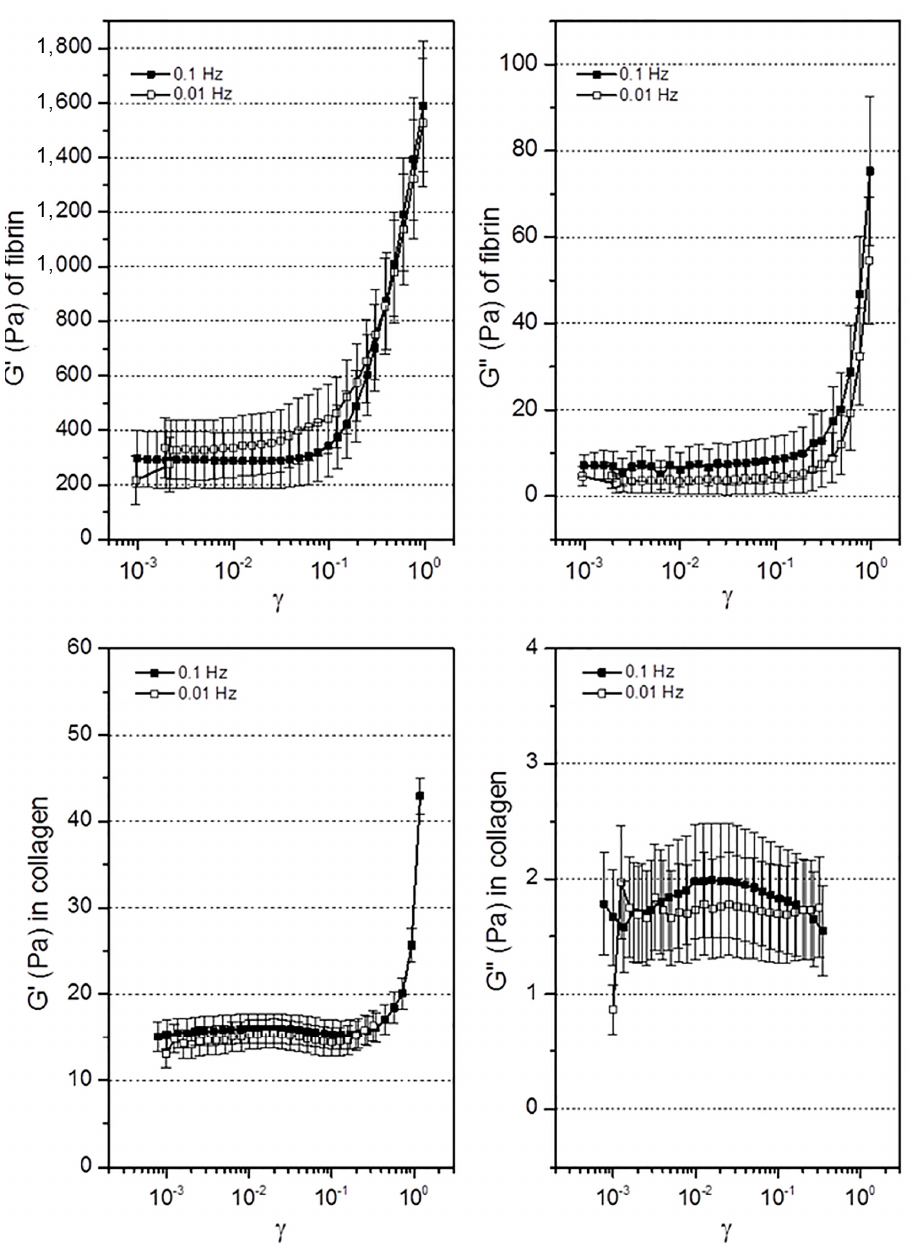
Figure 8. Strain sweeps of hydrogels. Elastic ( G’ ) and viscous ( G’’ ) shear moduli are shown as a function of the strain amplitude ( γ ) in parts per unit at frequencies of 0.1 Hz and 0.01 Hz. The temperature during the experiments was maintained at 37 °C. Strain hardening of fibrin and collagen occurred at 10% and 50% strain, respectively. In the elastic range, the elastic shear modulus was 300 and 15 Pa,